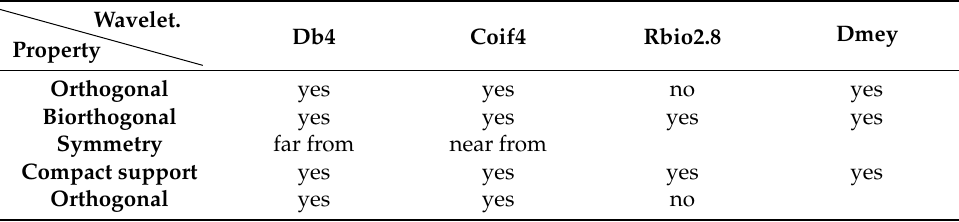
Table A2. Properties of different wavelet